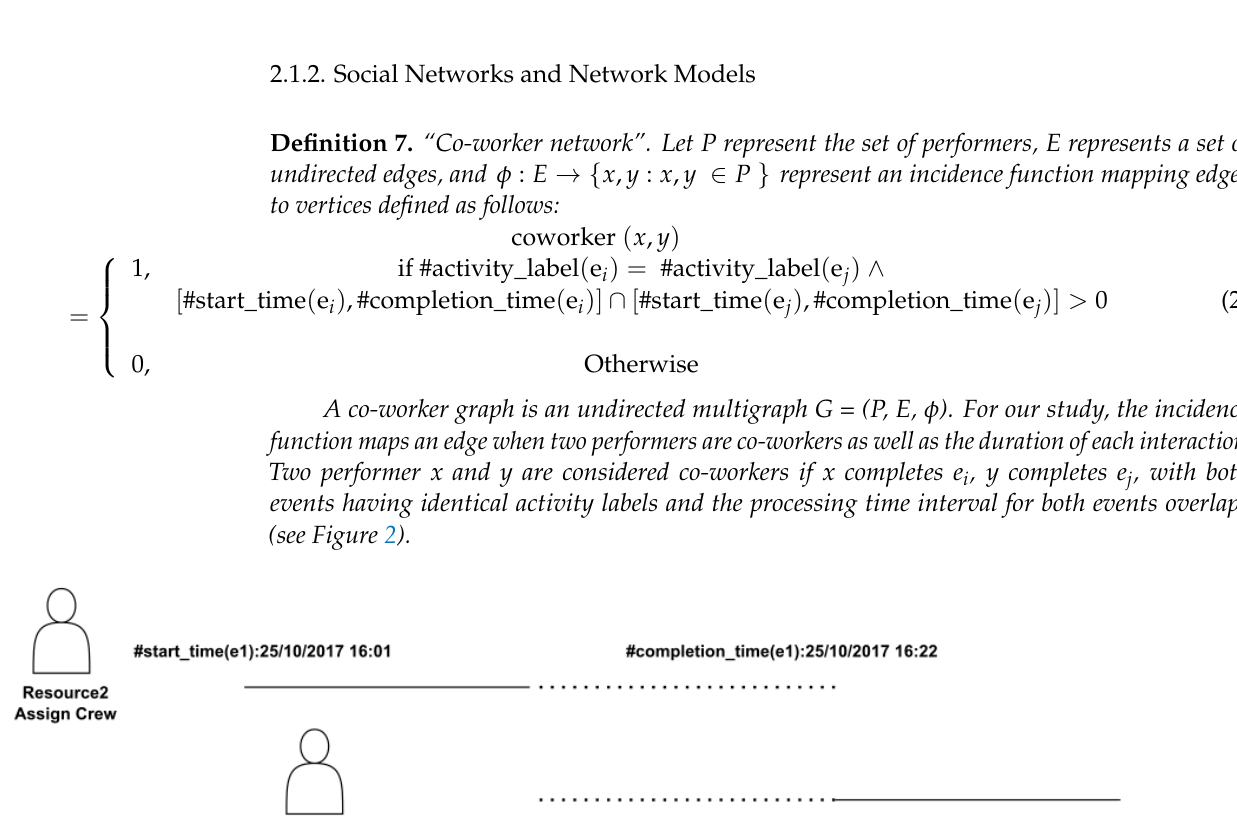
Table 1. Event Log Example.